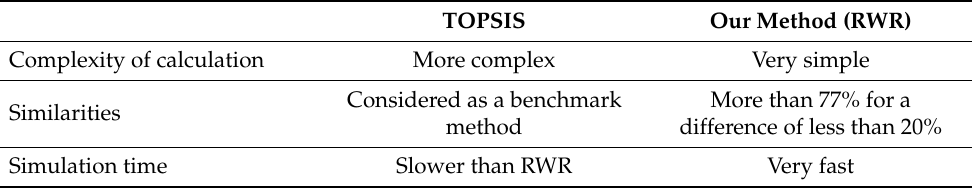
Figure 10. Impact of doubling the number of alternatives and criteria on the simulation time of RWR and TOPSIS. ( a ) normal scale, ( b ) logarithmic scale base 2. Table 7. Impact of doubling the number of alternatives and criteria on the simulation time of RWR and TOPSIS. Table 8. Summary of the comparison between RWR to